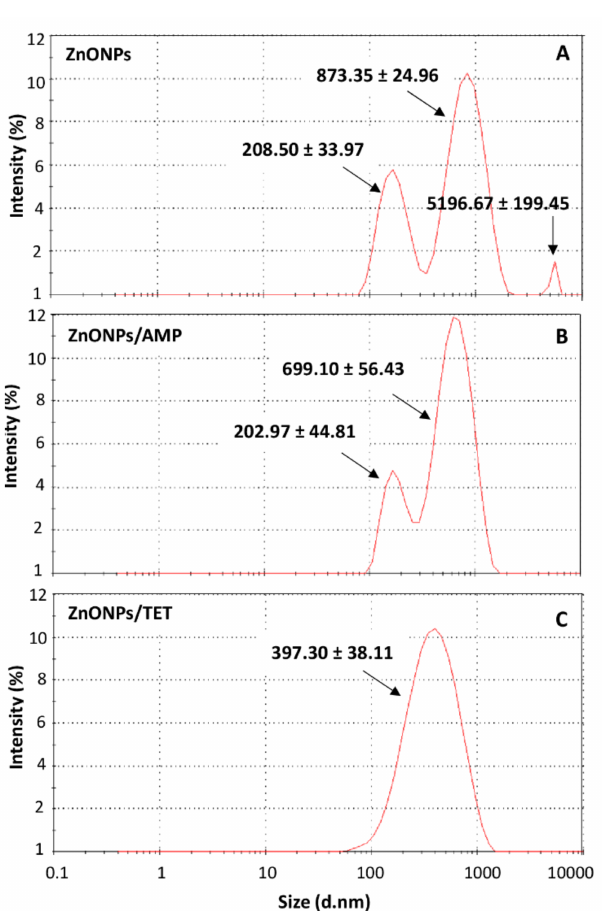
Figure 2. Hydrodynamic size distribution of zinc oxide nanoparticles ( A ), zinc oxide nanoparticles immobilized with ampicillin ( B ) and zinc oxide nanoparticles immobilized with tetracycline ( C